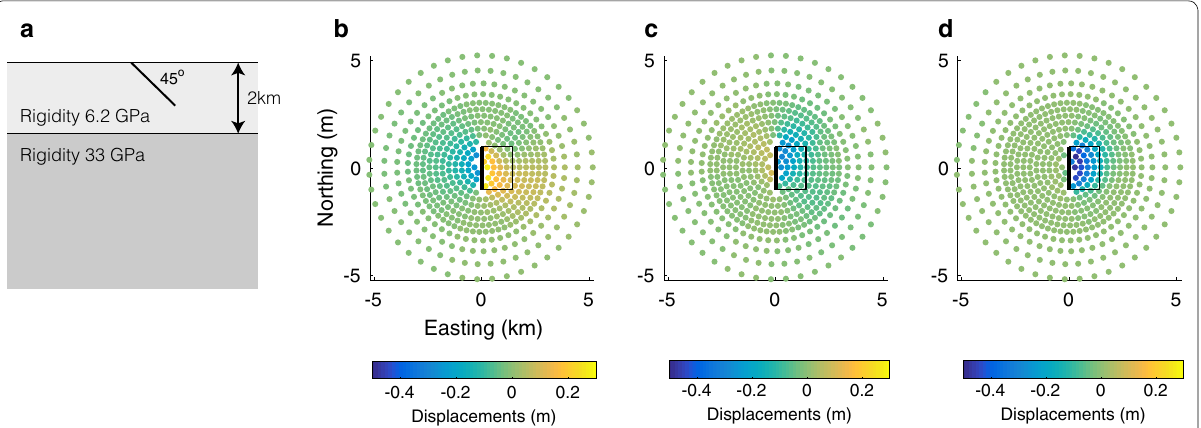
Fig. 12 a Model assumptions of the synthetic test. b – d Example of synthetic data used for the inversion of the synthetic test, for the case where the width is 2 km. Eastward ( b ), northward ( c ), and vertical ( d ) displacements are shown. Black rectangle shows the location of the fault, with the thick line denoting the fault